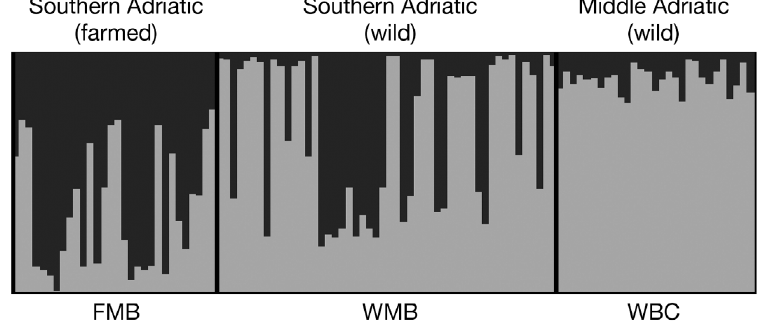
Fig. 3. Proportional membership of each individual gilthead sea bream Sparus aurata from the Adriatic Sea in 2 clusters identified by the software STRUC- TURE. Regional subdivision (above the graph) and origin locality of each individual (below the graph) are indicated. See Table 4 for